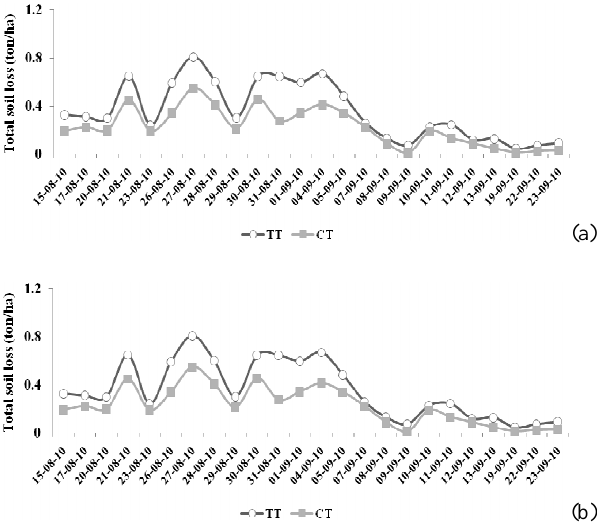
Figure 9. Soil loss as affected by tillage treatment (a) wheat and (b) tef. Note the higher difference in wheat than in tef as influenced by seedbed compaction during tef planting and at earlier stage than at later due to reduced soil loss with increasing crop cover.